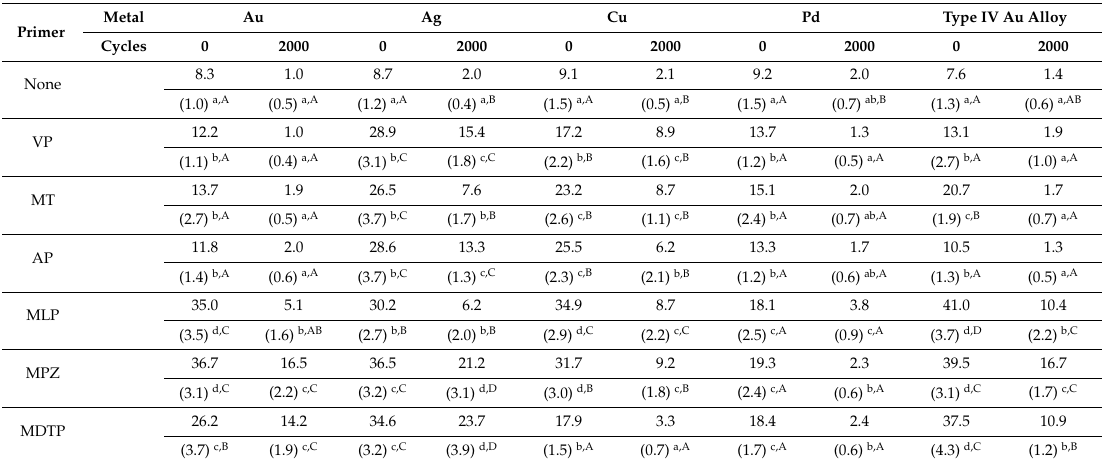
Table 3. Mean (SD in parenthesis) values of shear bond strength for test groups. Primer